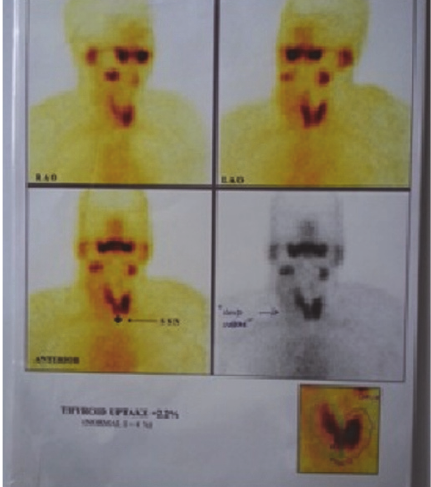
Figure4:Tc99mscintigraphyshowingnormaluptakeinthethyroid gland, a cold nodule in the right lobe, and normal activity in the salivary